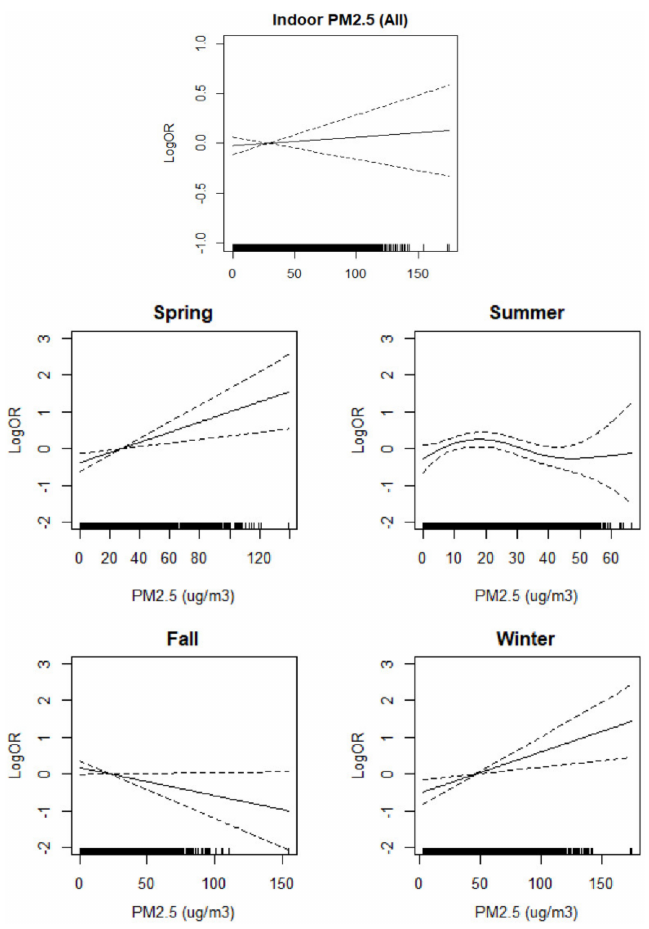
Figure 1. Relationship of indoor PM 2.5 with atopic dermatitis (AD) symptoms. Each figure shows the spline curves (solid lines) with 95% confidence intervals (two dashed lines). The model was controlled for the severity score at the initial visit, age, sex, presence of fever, and day of week (DOW), indoor RH, temperature, and formaldehyde; OR: odds